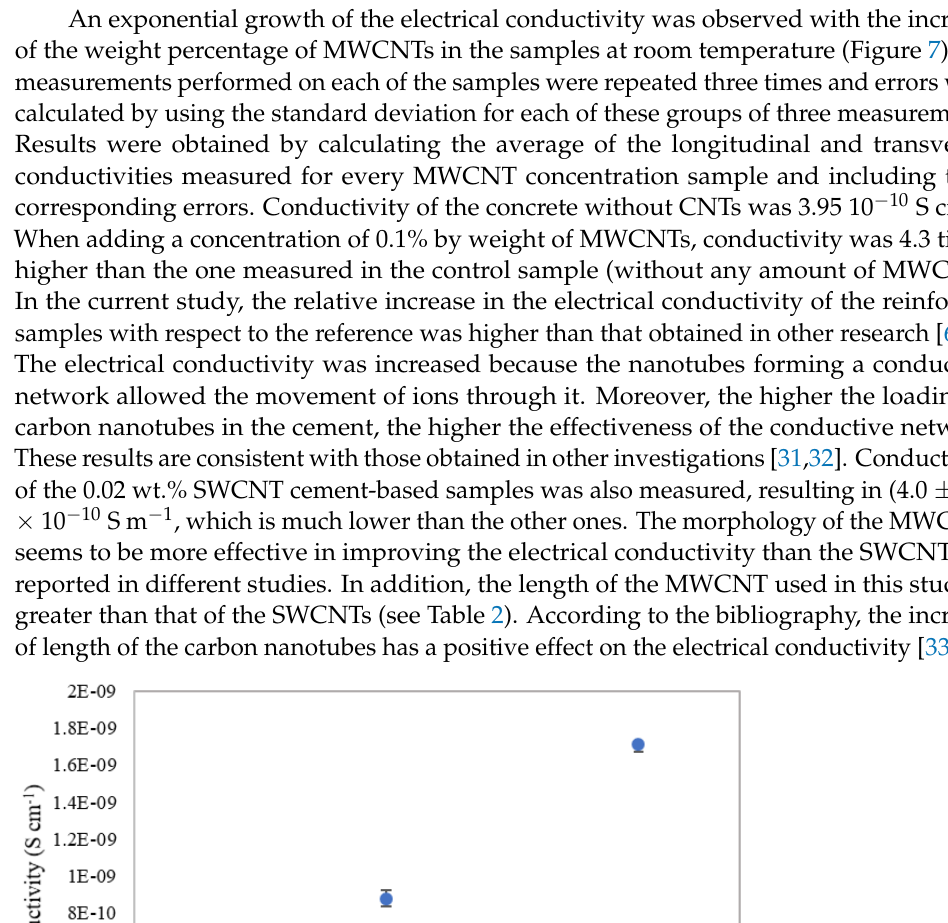
Figure 6. Thermogravimetric curves for the control sample, the 0.05 wt.% MWCNTs and the 0.1 wt.% MWCNTs reinforced cement samples, after 28 days of curing time.